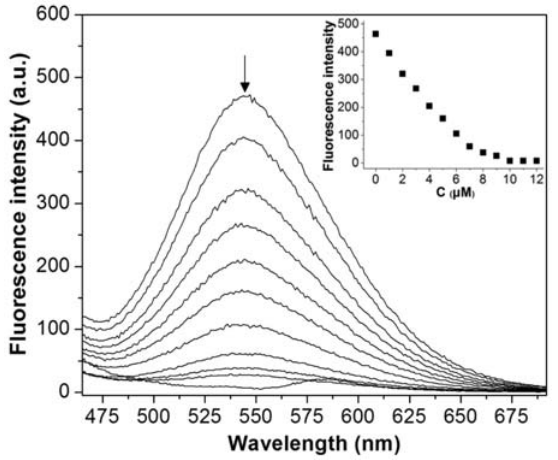
Figure 3. Fluorescence titration spectra of RD (10 μM) with Cu 2+ (0–12 μM). Inset: the fluorescent intensity at 545 nm as a function of Cu 2+ concentration.